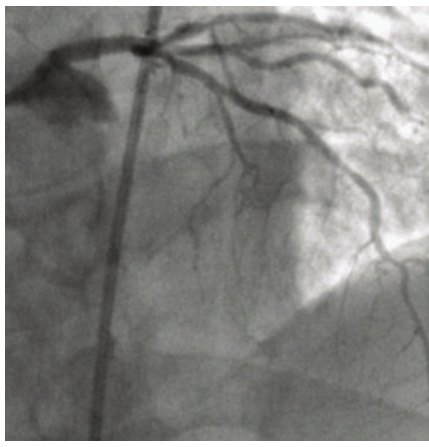
Figure 3: Left main coronary artery